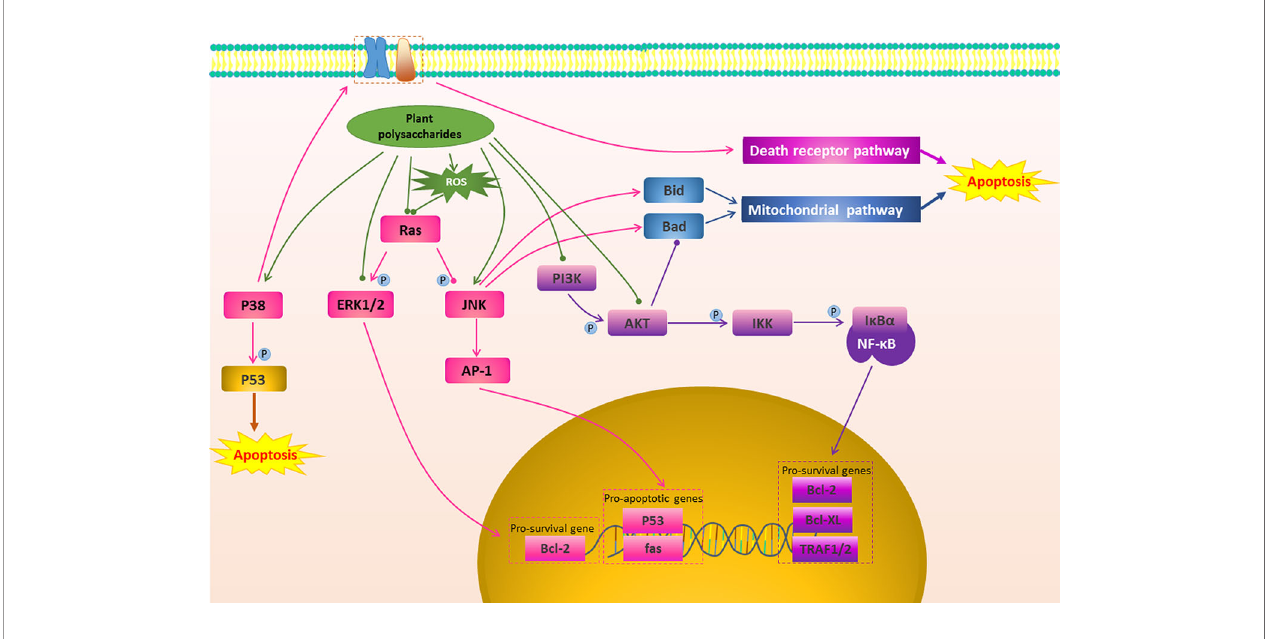
FIGURE 3 | The regulation of other apoptosis signal conduction in cancer by plant polysaccharides with different colors indicate inhibition/reduction, and with different colors indicate